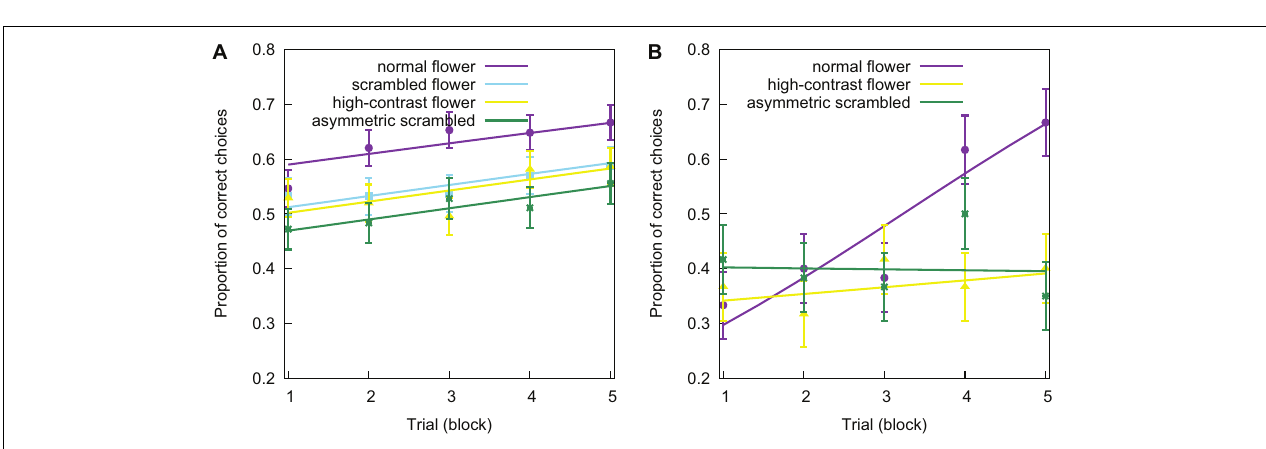
FIGURE 3 | The rotating screen apparatus (50 cm diameter) which was used in all experiments. In this diagram, the apparatus is shown with two identical normal flower stimuli which would be the correct option and two different but identical normal flower stimuli which would be the incorrect option (A) . The flower stimulus which was correct was pseudo-randomised between bees. The reward (drop of sucrose solution) was provided on the landing platforms. (B) Shows the apparatus from the side.